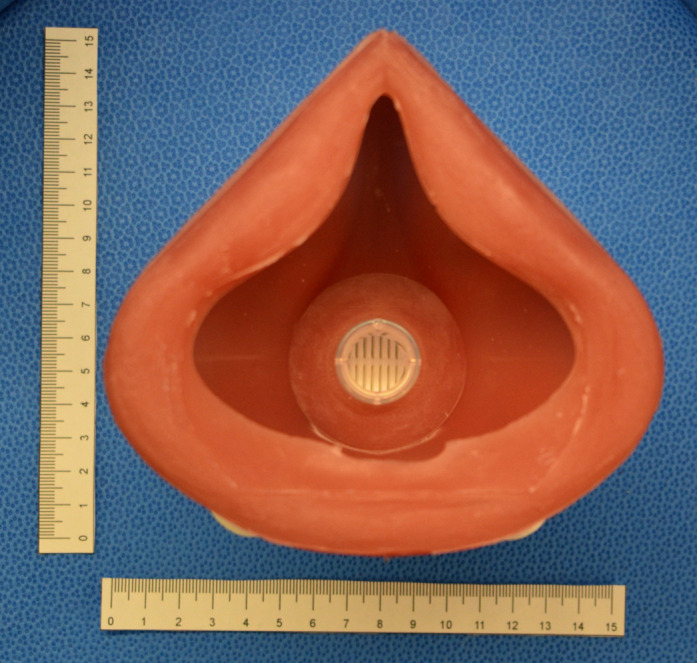
Inside of the silicone mask body.